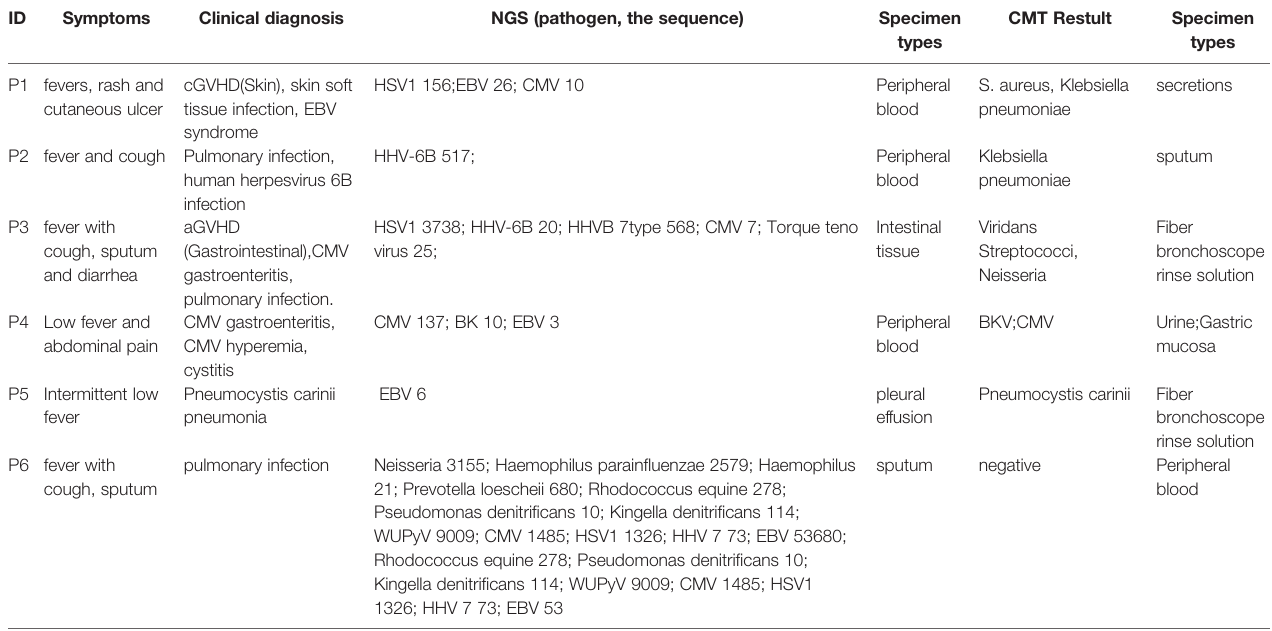
TABLE 3 | Details of patients with different types of